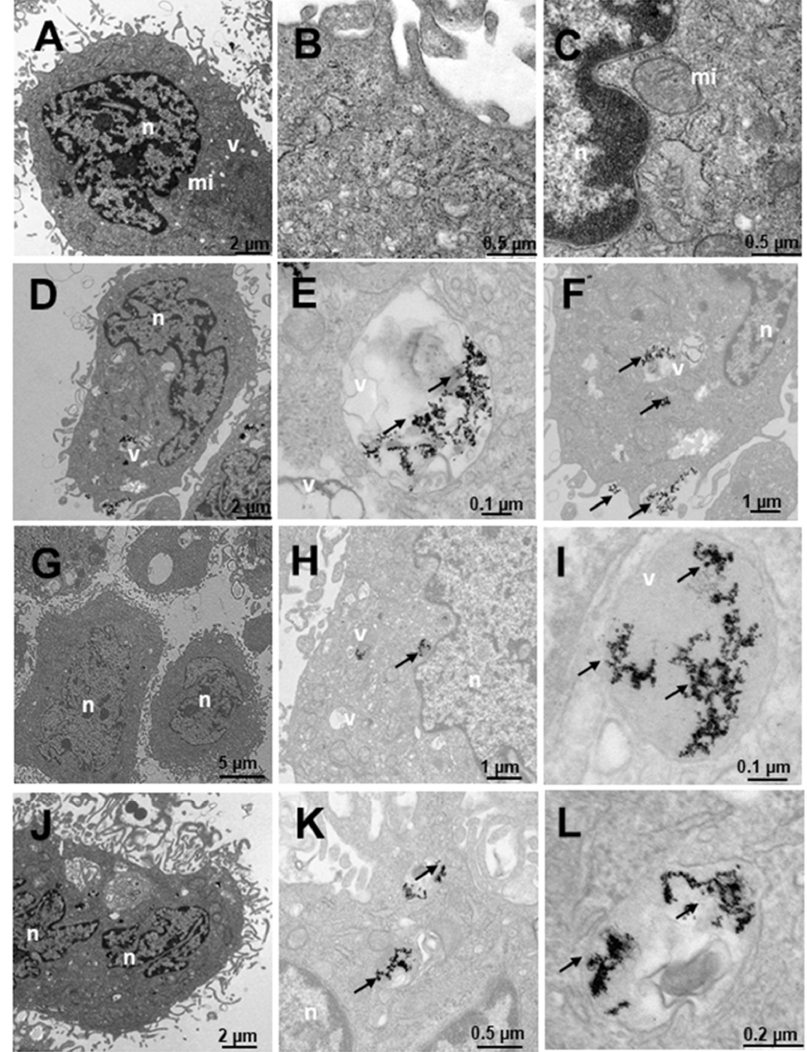
Figure 13. Transmission electron microscopy (TEM) photomicrographs of control cells without treatment ( A – C ), compared to Au@16-Ph-16 (N 3 ) ( D – F ), Au@16-Ph-16/DNA/Doxo (C 3 ) ( G – I ) and Au@16-Ph-16/DNA/Doxo + Au@16-Ph-16 (C 3 + N 3 ) ( J – L ) at 24 h, in SNU387 cells, derived from liver tumor, a model of high-grade hepatocarcinoma. The dense bodies indicated by an arrow are compatible with the gold core of the nanoparticles. Abbreviations: mi—mitochondria, n—nucleus and v—vesicles.